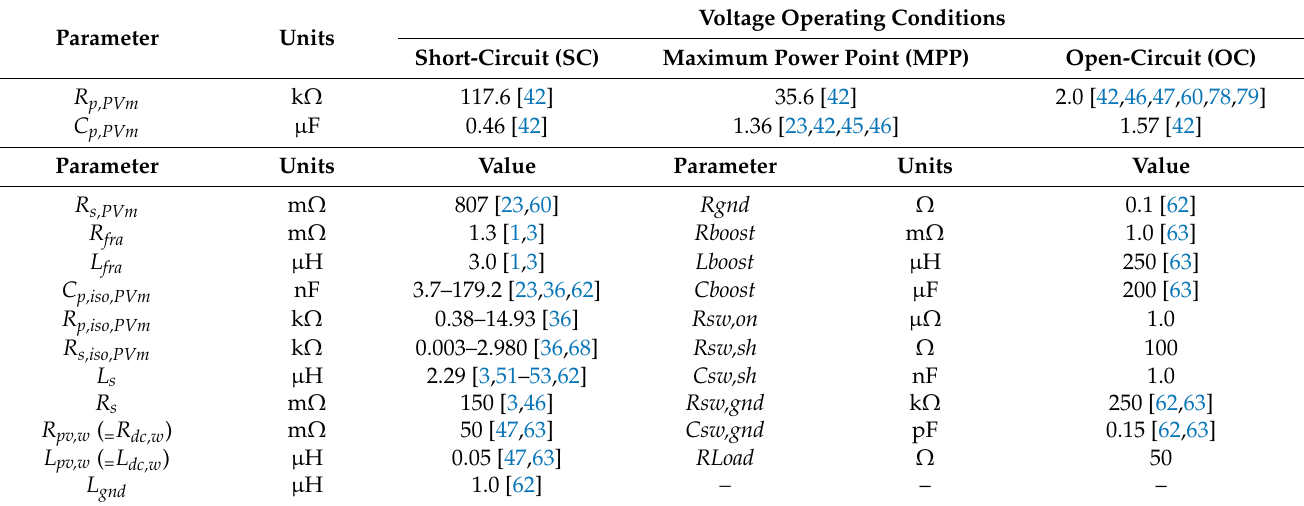
Table 2. Value setting adopted for parameters in simulations (Irradiation: 100 W/m 2 ; frequency: 1 MHz).